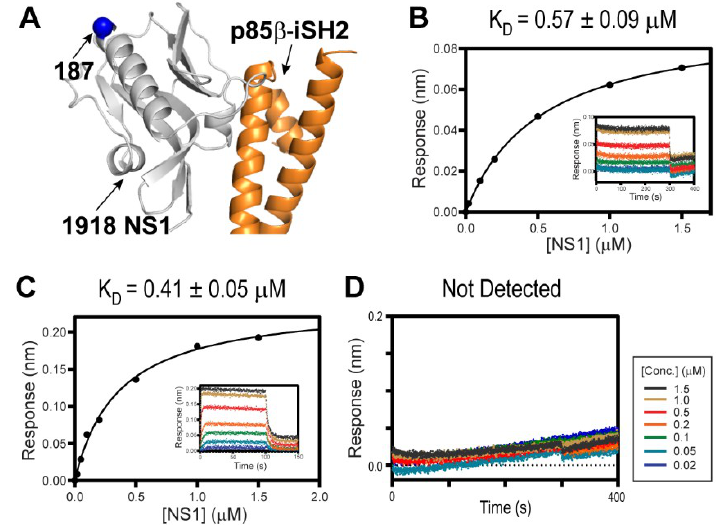
Figure 2. Interaction between 1918 NS1 and p85 β (PDB ID: 6U28). ( A ) Crystal structure of the 1918 NS1 ED-CTT :p85 β iSH2 complex. The position of residue 187 is shown as a blue sphere. Biolayer interferometry (BLI)-derived binding isotherms of ( B ) 1918 NS1E D-CTT and CRK-II, ( C ) 1918 NS1 ED-CTT and CRK-L. Insets: representative BLI sensorgrams with di ff erent analyte concentrations are shown by di ff erent colors. K D values and uncertainties are the global fitting result of three repeated data. ( D ) BLI sensorgram of 1918 NS1 ED- ∆ CTT binding to CRK-L.